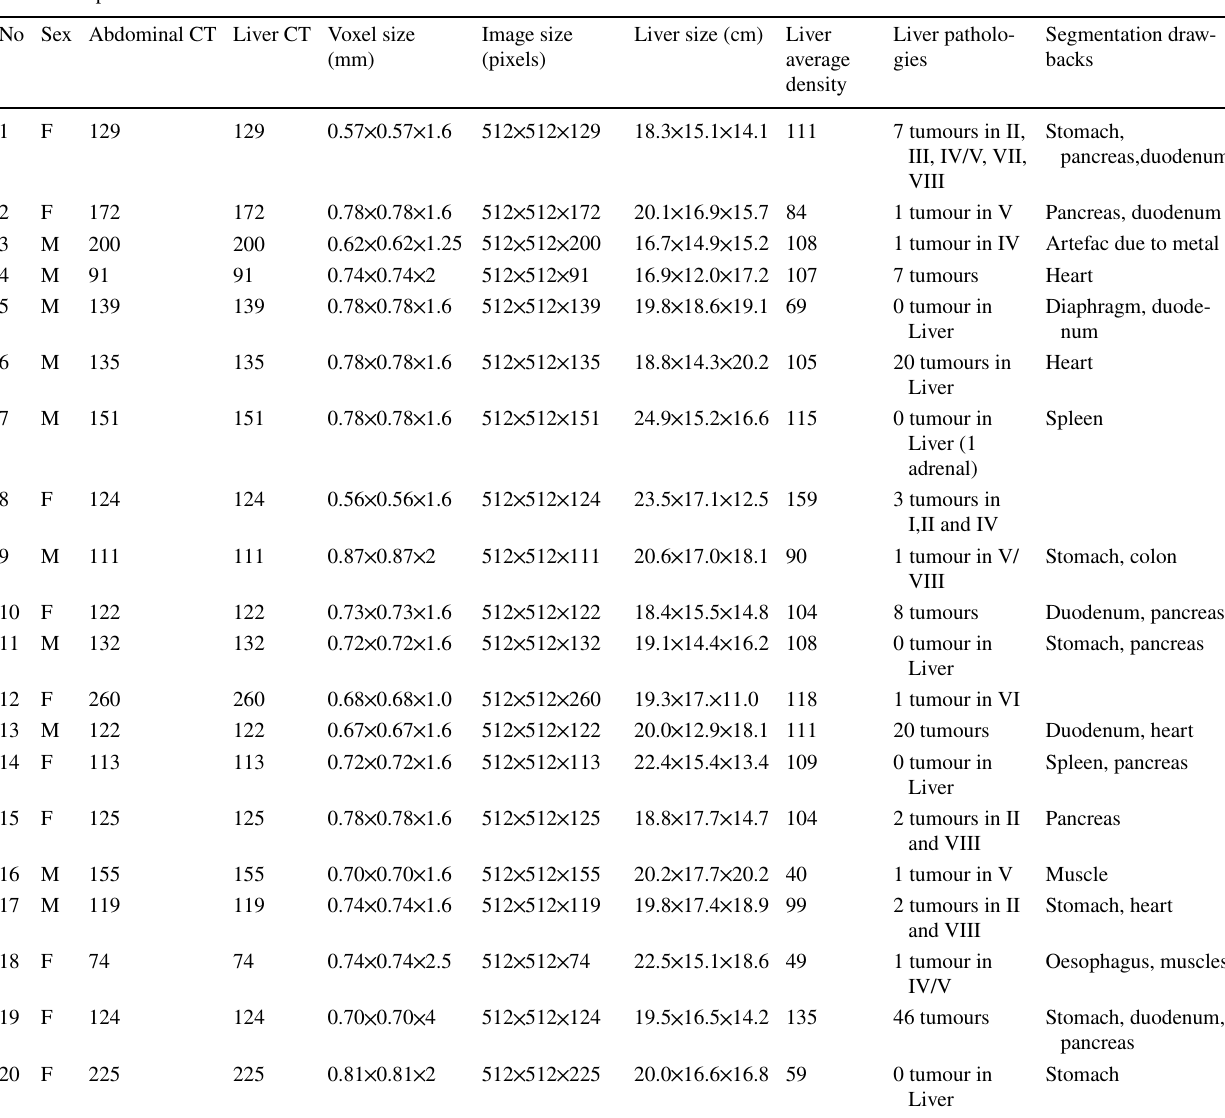
Table 1 Experimental data Set No Sex Abdominal CT Liver CT Voxel size